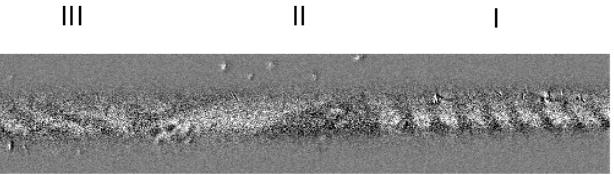
Figure 12. Experimental picture of coexistence of three types of surfaces of domain structure: cylin- drical ( I ), spiral ( II ), elliptic ( III ). Reprinted with permission from